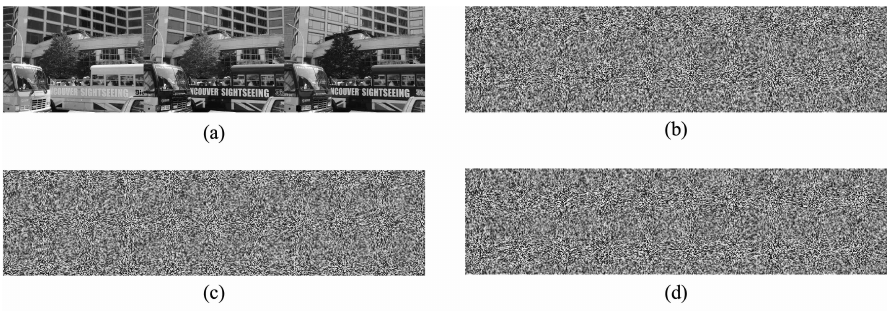
Figure 11. Marked encrypted images (ihc5 (1/16)). ( a ) Grayscale-based image; ( b ) L = 1, ( c ) L = 3; ( d ) L = 10.